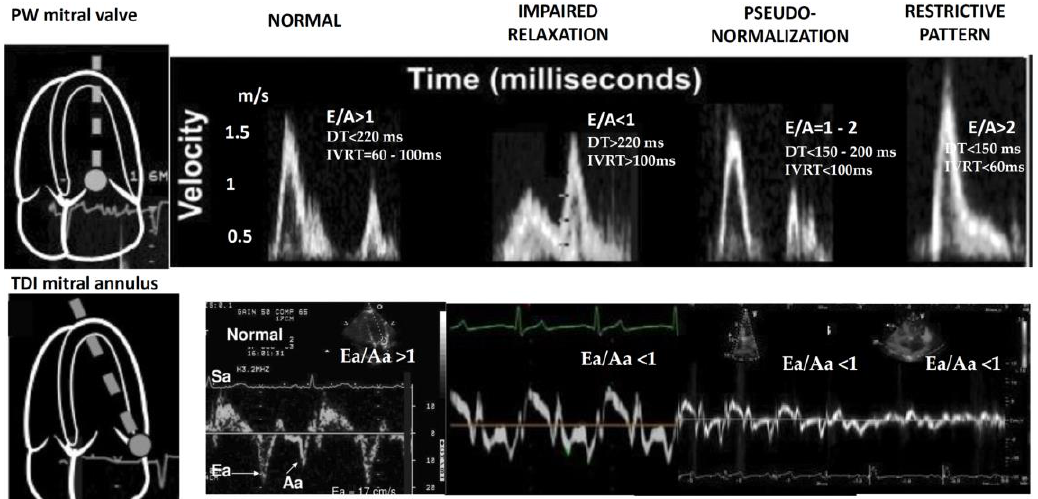
Figure 1. Diastolic filling patterns evaluated by pulsed-wave Doppler and TDI. All patients over 35 years of age, as well as patients under 35 years old with angina pectoris, underwent arteriography. None of the patients had associated coronary artery disease (>50% reduction in luminal diameter of any coronary artery). For patients present- ing with symptoms suggestive of heart failure and preserved systolic function, brain na- triuretic peptide (BNP) titration was performed. Diastolic heart failure was considered unlikely for values under 35 pg/mL and possible if values surpassed 100 pg/mL. 2.4. Statistical Analysis Statistical analyses were performed using SYSTAT and the Statistical Package for the Social Sciences 11.5 (SPSS 11.5) software. Continuous variables were indicated as means ± standard deviations, and qualitative data were recorded as percentages. Categorical vari- ables were tested using the Pearson chi-square test, likelihood ratios and Fisher ’ s exact test, and quantitative data between the two groups were tested with the independent- samples t -test, while data between three groups were tested with analysis of variance (ANOVA) and Tukey ’s post hoc test, assuming equal variances, and the Games – Howell post hoc test, assuming nonequal variances between the groups. The Wilcoxon test and the Friedman test were used to compare preoperative and postoperative echocardio- graphic variables. The association between preoperative variables and postoperative change in LVEF was based on Pearson correlation analysis, and linear regression analysis was used to es- tablish the associations between preoperative data and the parameters associated with postoperative evolution (death, NYHA class and quality of life). Univariate logistic re- gression analysis was used to compare the two groups. Multivariate logistic regression analysis was performed to identify predictive factors of mortality. Areas under the re- ceiver-operating-characteristic (ROC) curves and Hosmer – Lemeshow goodness-of-fit sta- tistics were calculated to assess the discrimination and calibration of the model, respec- tively. To evaluate the goodness-of-fit of the model, Cox – Snell/Nagelkerke values were calculated. A probability value of <0.05 was considered statistically significant. We tested two main hypotheses. The first was that LA dilatation and restrictive LVDFP are independent predictors for unfavorable postoperative evolution in patients with AS and LV systolic dysfunction undergoing AVR. The second hypothesis tested was that the presence of restrictive LVDFP makes a higher contribution than LV systolic dys- function to preoperative risk calculations for patients with AS undergoing AVR. For hy- pothesis testing, we used univariate and multivariate logistic regression analysis, correla-